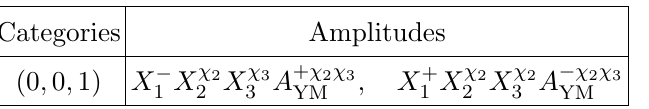
Table 1 . List(+ (cid:0) ; + (cid:0) ; + (cid:0) ).